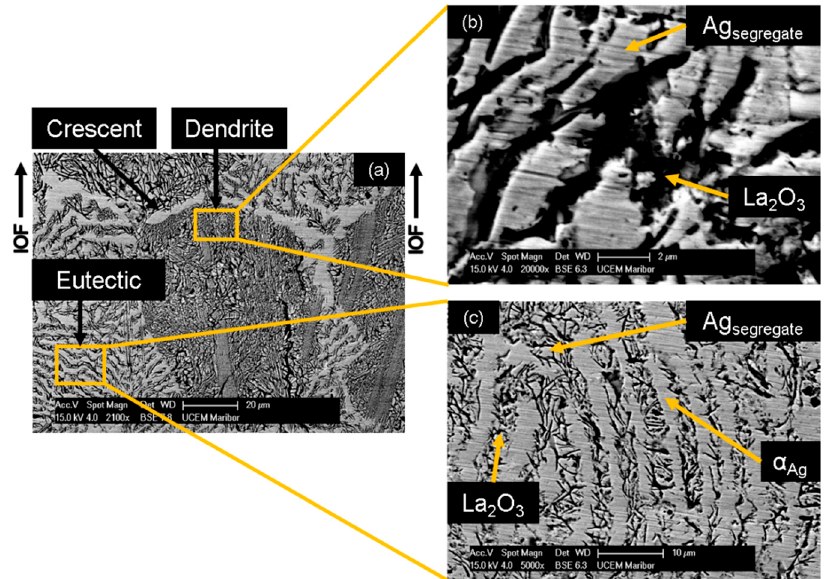
Figure 13. SEM micrograph of a hypereutectic microstructure: ( a ) overview of the completely oxidised microstructure; ( b ) detailed micrograph from the oxidised dendrite; ( c ) detail from the oxidised lamellae in the eutectic.